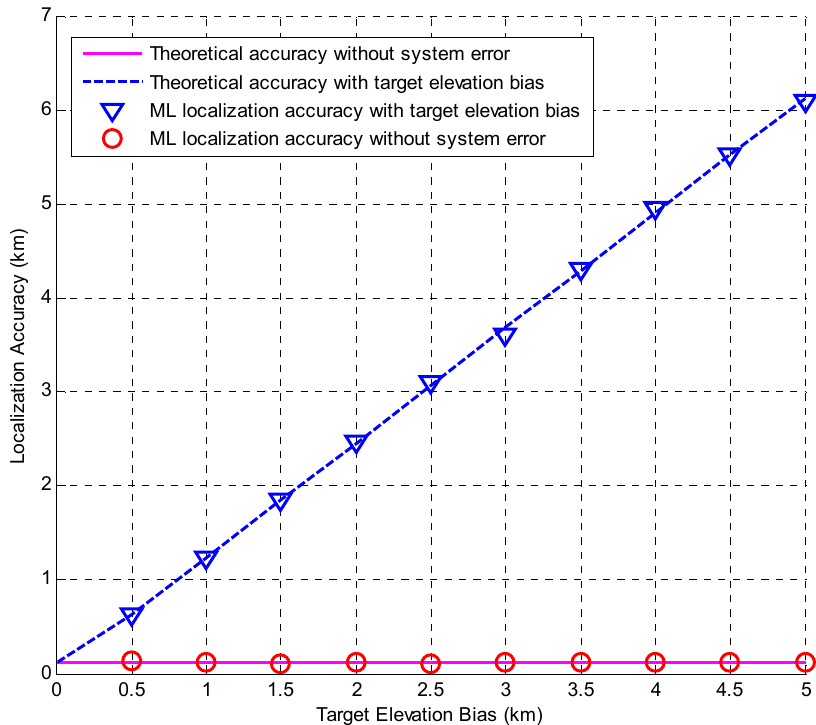
Figure 10. Comparison of velocity estimation using LEO satellite, airplane and ground station by varying TDOA measurement noise.